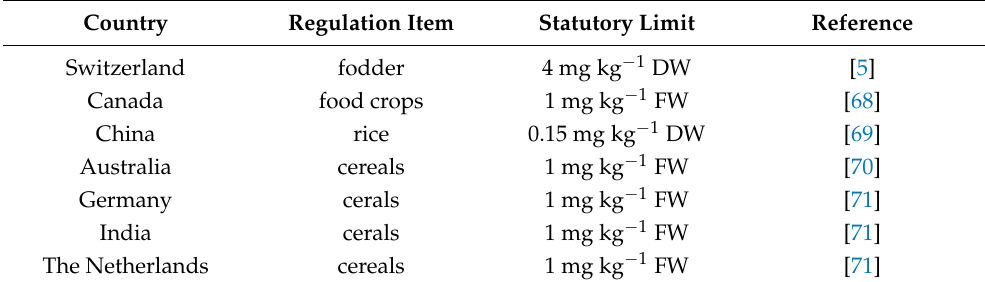
Table 2. Regulation limits of As concentration in cereals or food crops established by different countries. Country Regulation Item Statutory